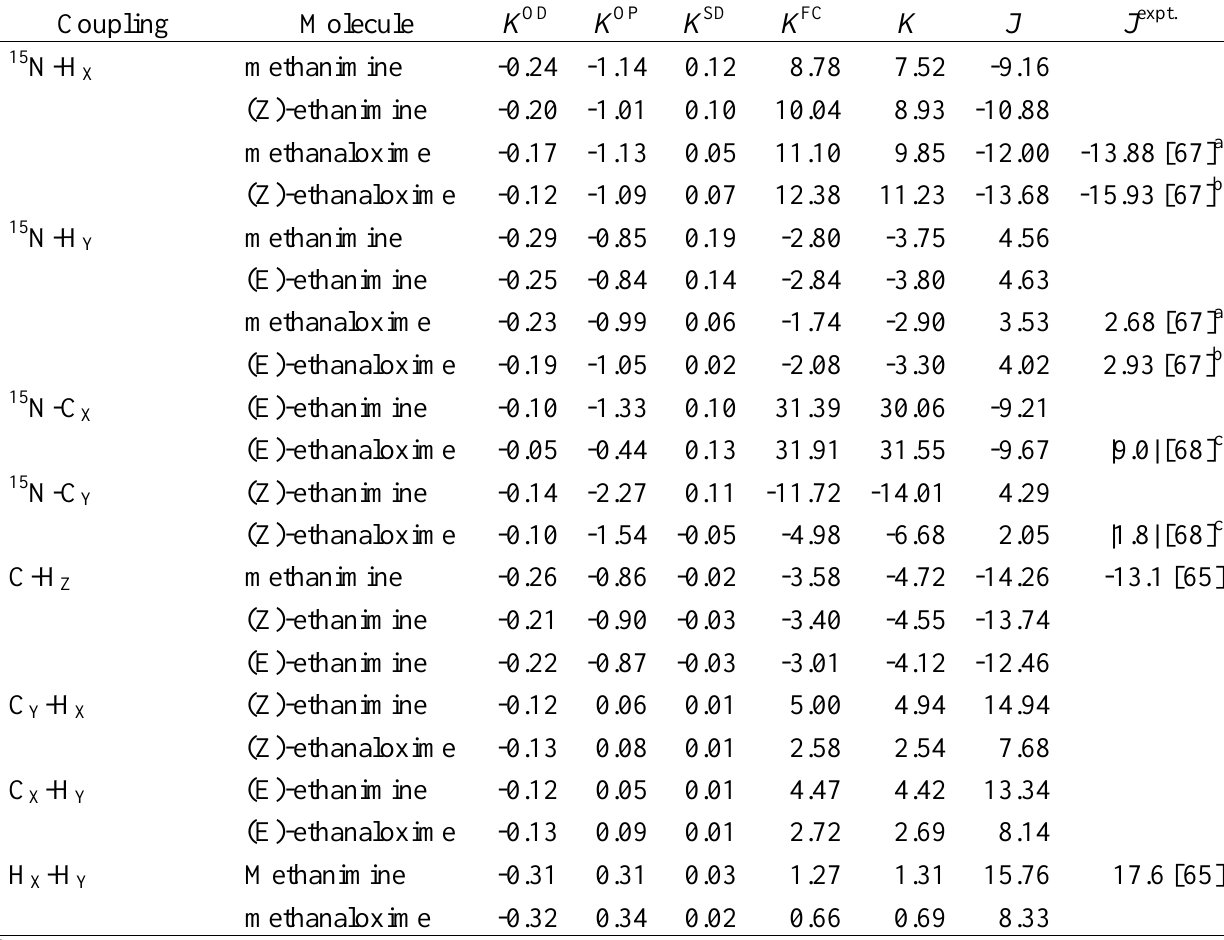
Table 3. Two-bond (geminal) spin-spin couplings calculated at SOPPA(CCSD) level. Coupling constants, J , in Hz and reduced coupling constants, K , in 10 19 T 2 J -1 .